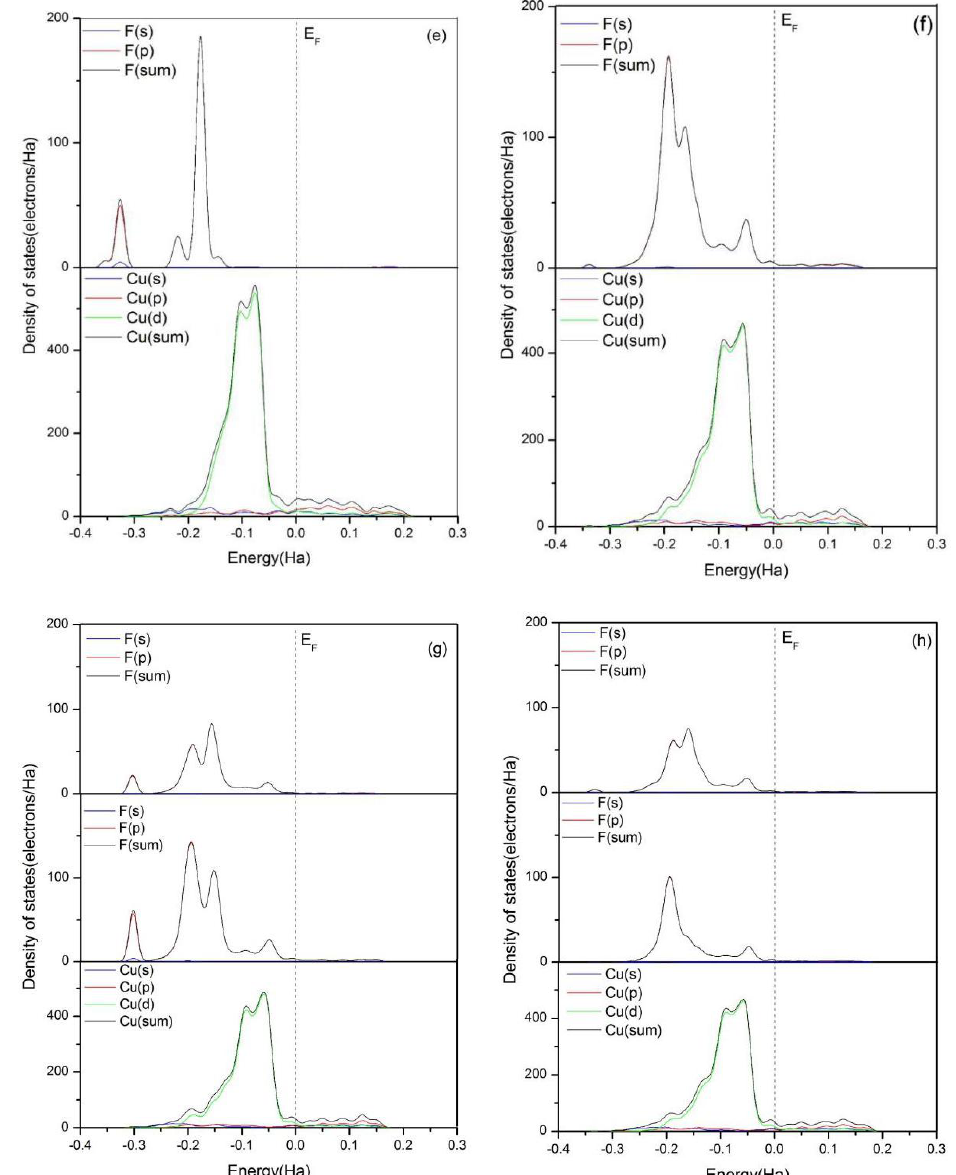
Figure 4. Total and partial density of states of F atom in HF, F atoms in PF 5 , which form bonds with Cu atoms, and Cu atoms in the topmost layer of clean Cu(111) surface (when the two kinds of F atoms exist together, the F from HF is above). ( a ) Clean Cu(111) surface, ( b ) H 2 O, ( c ) HF, ( d ) PF 5 , ( e ) HF and H 2 O, ( f ) H 2 O and PF 5 , ( g ) HF and PF 5 , and ( h ) HF, H 2 O, and PF 5 .